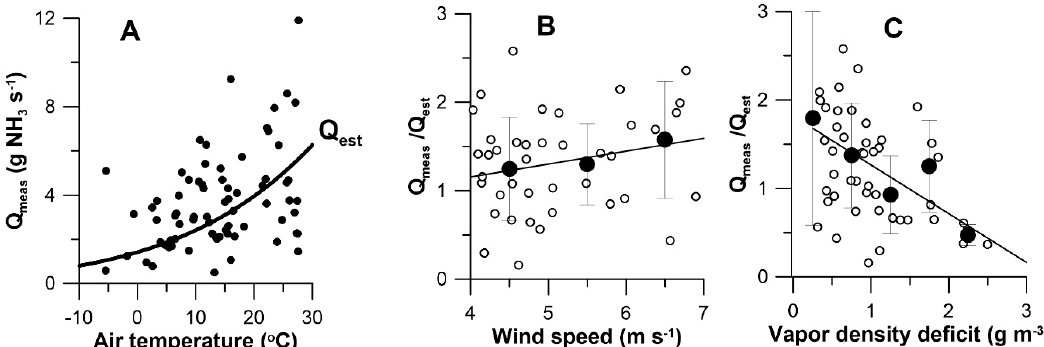
Figure 6. Influence of air temperature, wind speed and saturation water vapor deficit on daily NH 3 emissions. Panel ( A ) illustrates the correlation between daily mean air temperature at 1 m height and daily mean emissions (open circle) and the best-fit emissions estimation model including only air temperature as variate (Equation (3) with α = 0.55; solid line). Panels ( B , C ) illustrate the relationship between the measured and modeled emissions and wind speed and saturation water vapor deficit (open circles). The ratio of measured and modeled emission (Q meas / Q est ) was classified (wind speed at 1 ms − 1 intervals and water vapor deficit at 0.5 gm − 3 intervals) with mean and standard deviation of the mean of each classified bin indicated. Linear regressions of the classified wind speed (between 4 and 7 ms − 1 ) on Q meas / Q est had an R 2 of 0.05. Linear regressions of the classified vapor deficit (between 0 and 3 gm − 3 ) on Q meas / Q est had an R 2 of 0.18.